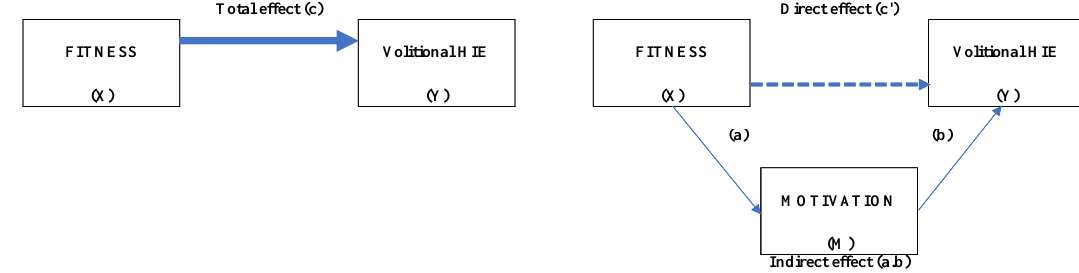
Figure 2. Conceptual model of mediation analysis: indirect effect through motivation.